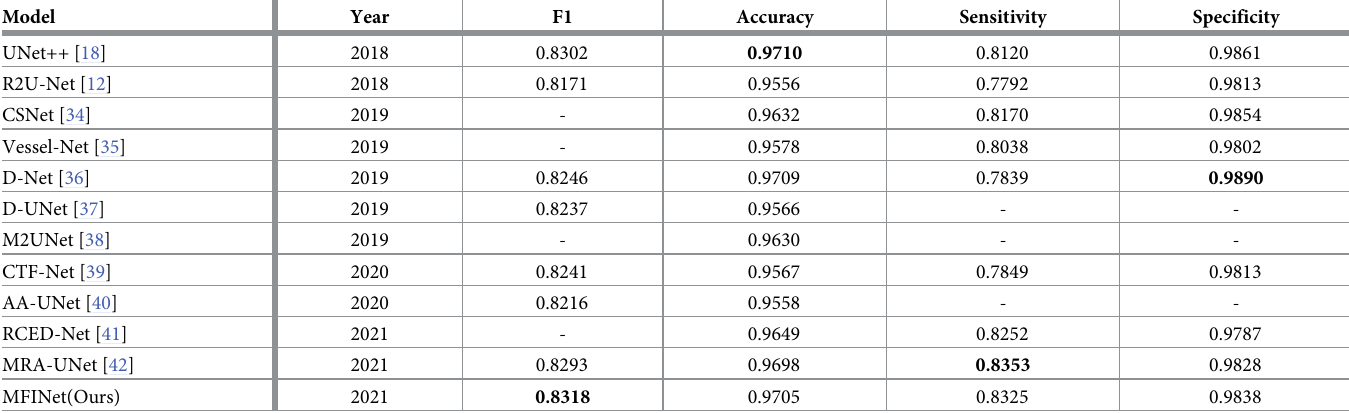
Table 3. Segmentation results of different models on the DRIVE dataset. Model